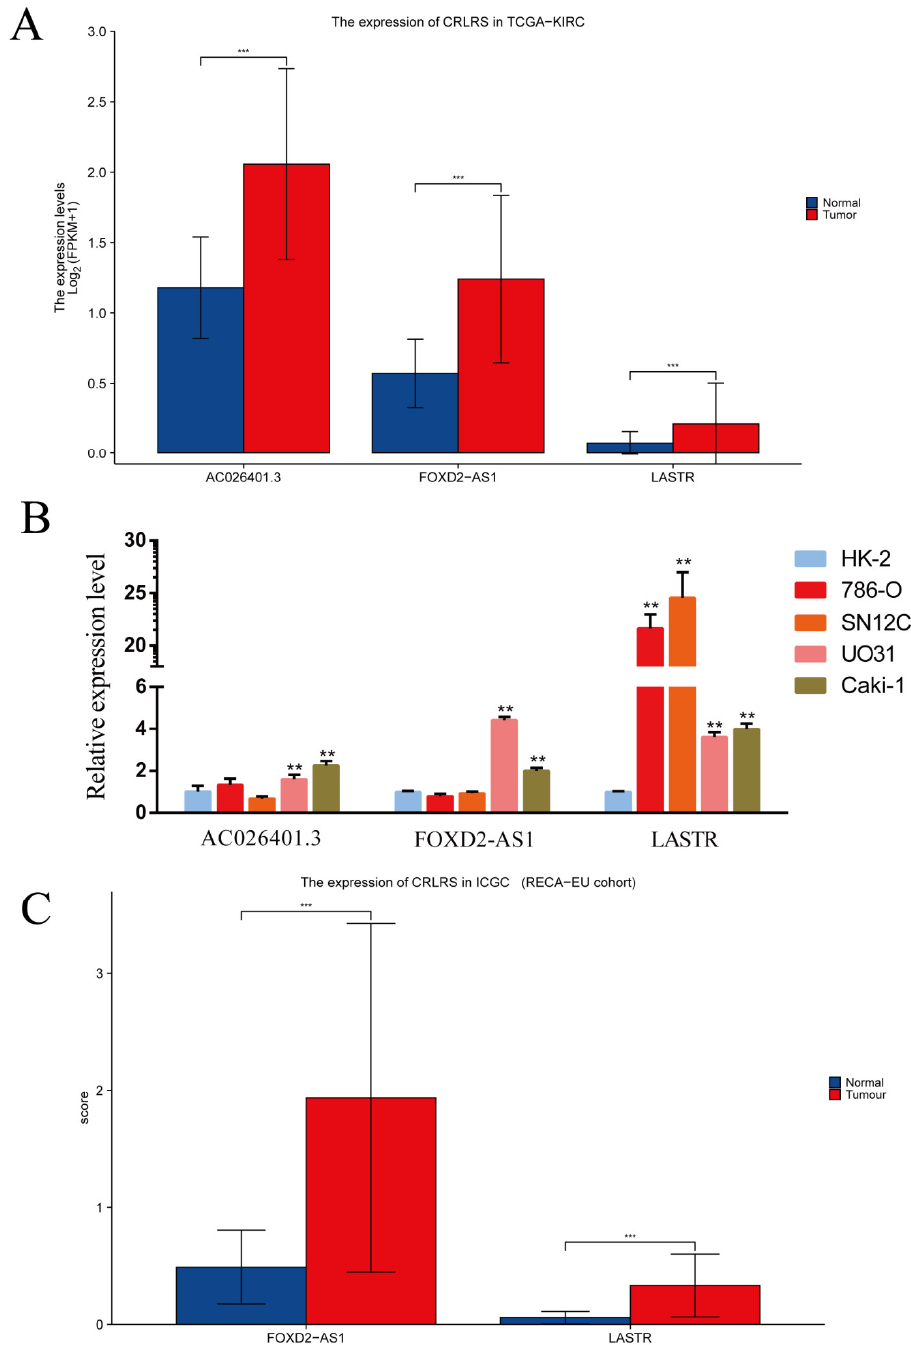
Figure 13. Validation of CRLRs in renal cancer. ( A ) Expression of CRLRs in TCGA-KIRC. ( B ) qPCR validation of CRLR expression levels in normal and renal cancer cells and expression levels of three CRLRs in HK-2, UO31, 786-O, SN12C, and Caki-1 cells (** p < 0.01, *** p < 0.001). ( C ) Expression of CRLRs in the ICGC (RECA-EU) cohort.